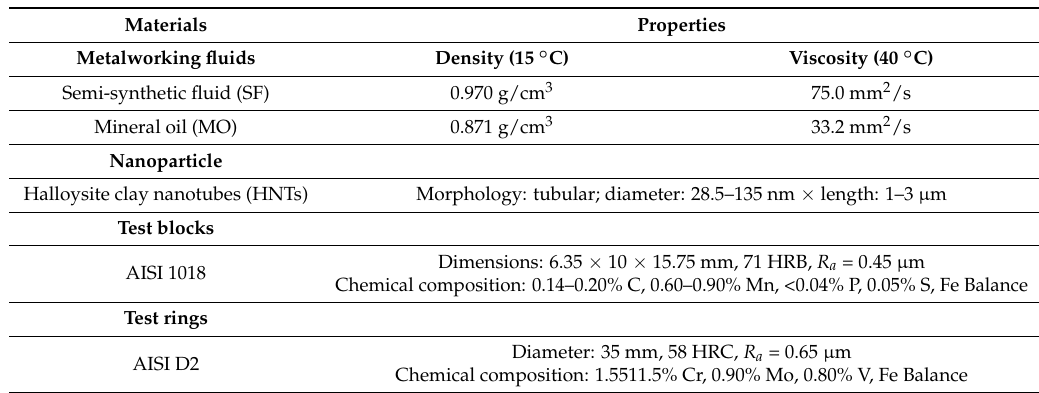
Figure 1. ( a ) Scanning electron micrograph of halloysite nanotubes (HNTs); ( b ) Micrograph of HNTs at higher magnification indicating nanoparticle dimensions; ( c ) elemental analysis of HNTs showing high concentrations of Al, Si, and O. Table 1. Material properties.